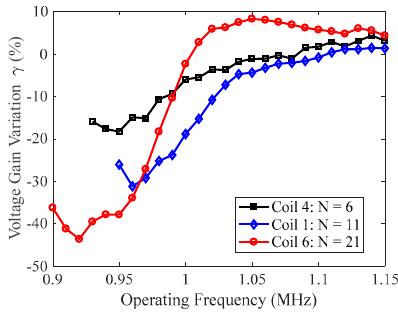
Figure 17. Measurements of γ varying with f for Coils 1, 3, and 5.